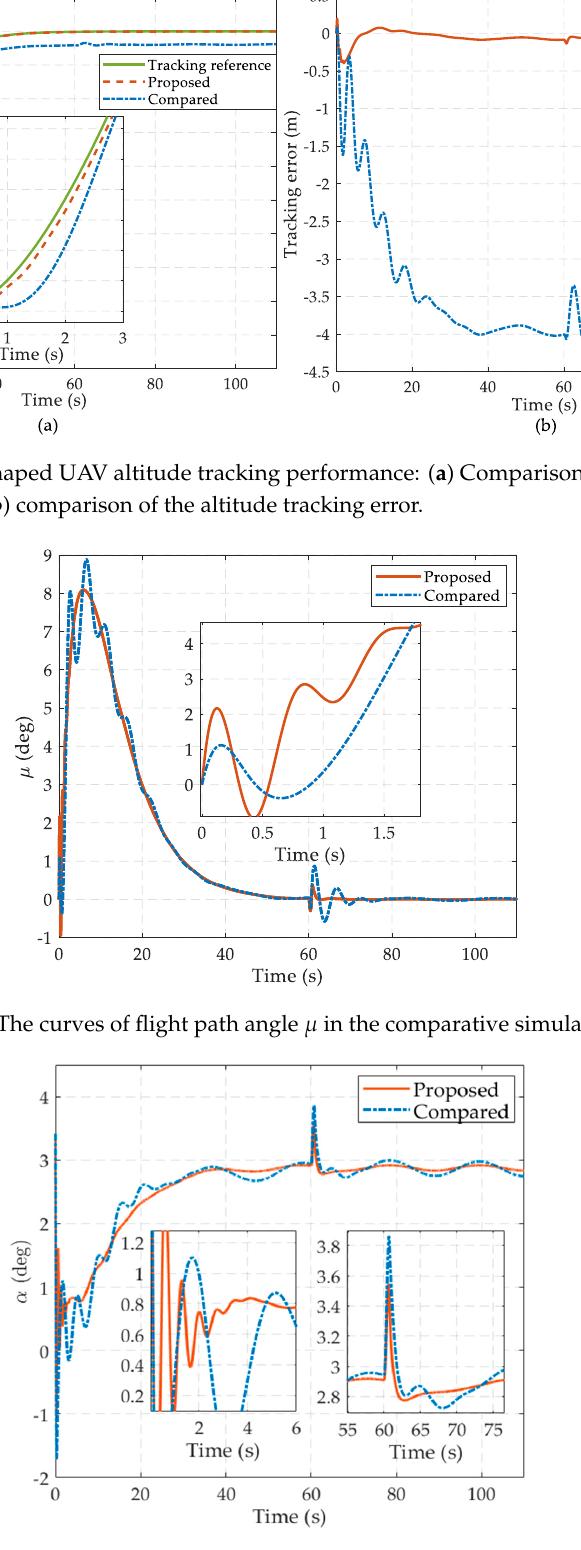
Figure 6. The curves of pitch angular rate q in the comparative simulations.